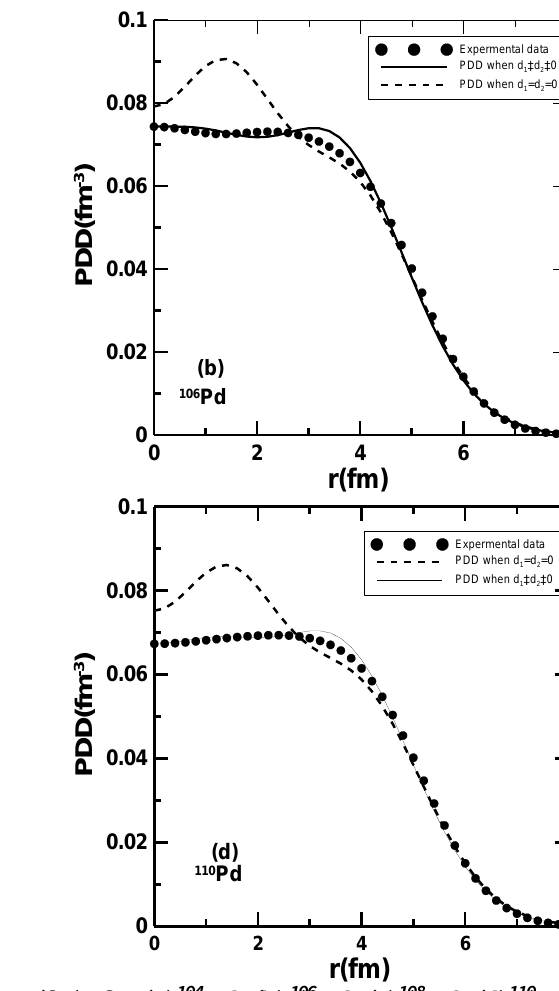
Fig.1: Dependence of the PDD (fm-3) on r (fm) for (a) 104 Pd, (b) 106 Pd, (c) 108 Pd, (d) 110 Pd nucleus. The dashed and solid curves are the calculated PDD of Eq. (3), when (d1, d2=0) and (d1, d2≠0), respectively. The dotted symbols are the experimental data of (FB) PDD of Ref.